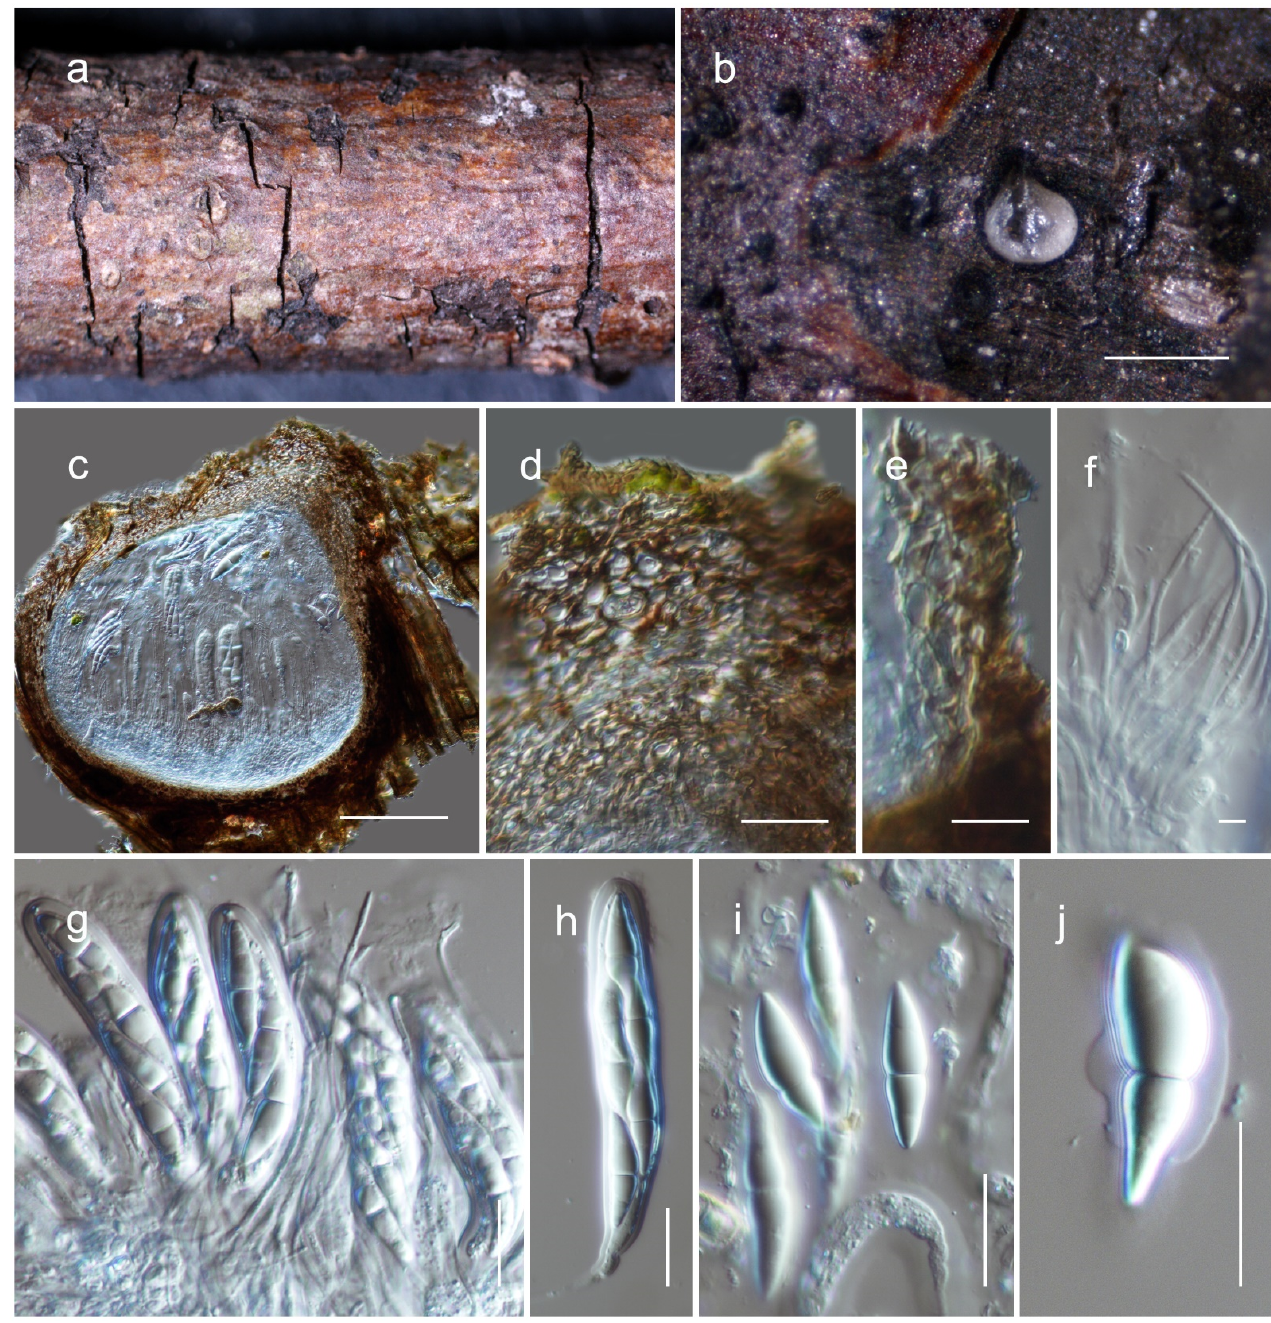
Figure 6. Loculosulcatispora hongheensis (HKAS122920, holotype). ( a ) Dead wood host substrate; ( b , c ) section of ascoma; ( d ); close-up of ostiole; ( e ) peridium; ( f ) pseudoparaphyses; ( g , h ) asci; ( i , j ) ascospores. Scale bars: ( b ) 500 μ m; ( c ) 100 μ m; ( d , g , h ) 20 μ m; ( e,i,j ) 10 μ m; ( f ) 5 μ